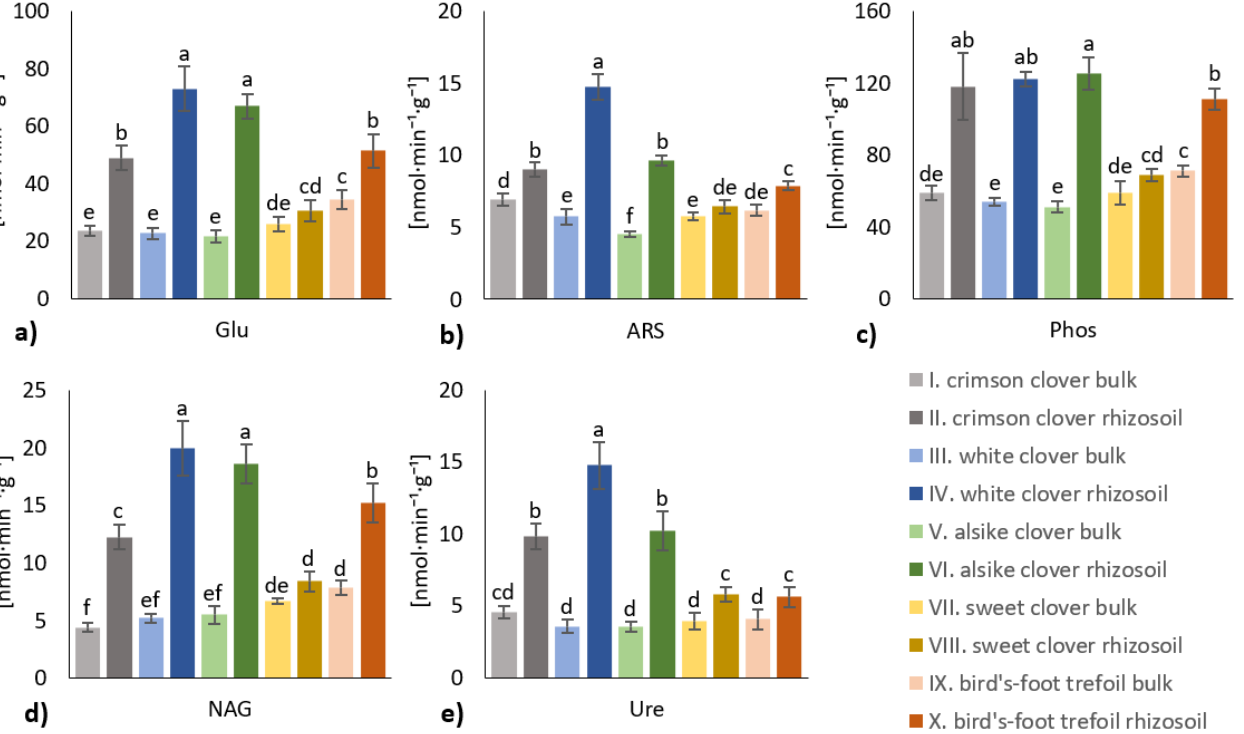
Figure 4. Soil enzyme activities in rhizosoil and bulk soil of experimental variants, collected from field cultures of various types of clover/legume crops after plant growth period 76 days: ( a ) β -glucosidase, ( b ) arylsulfatase, ( c ) phosphatase, ( d ) N-acetyl- β -D-glucosaminidase, ( e ) urease. Values (displayed in nmol ⋅ min − 1 ⋅ g − 1 ) were calculated as average from independent replicates (n = 27), error bars represent standard deviation. The different letters express the statistical differences at significance level p ≤ 0.05.